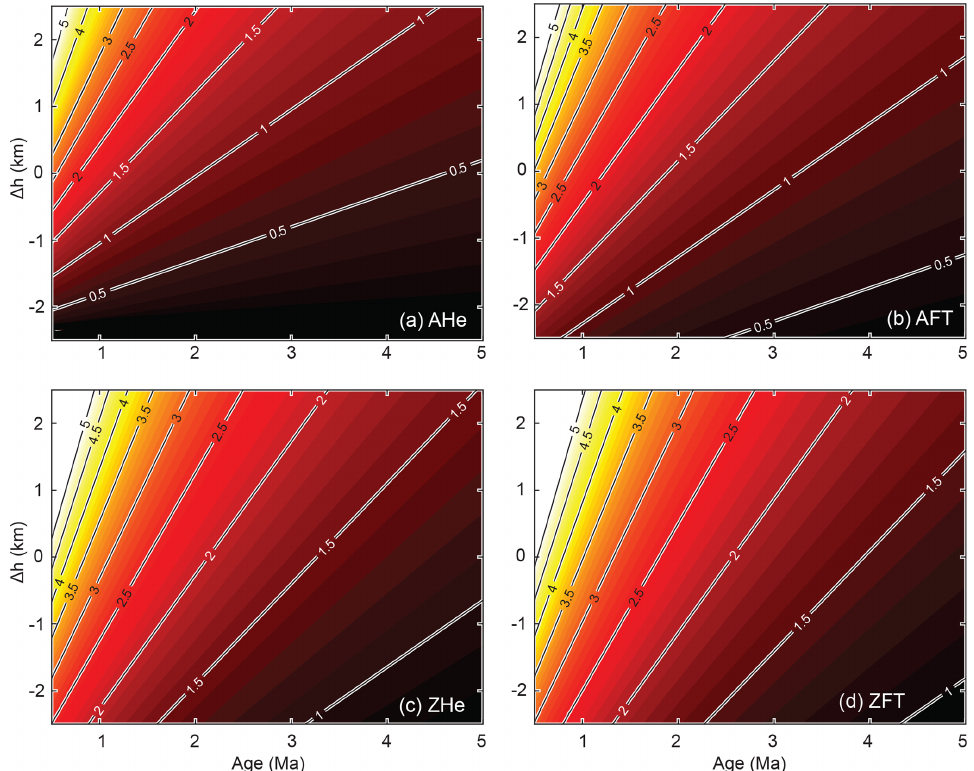
Figure 3. Contour plots of exhumation rate for different age– (cid:49)h combinations, zooming in on rapid rates and young thermochronologic ages ( < 5Ma). Plots are shown for the (a) AHe, (b) AFT, (c) ZHe, and (d) ZFT systems; exhumation-rate contours are shown every 0.1kmMyr − 1 from 0 to 5kmMyr − 1